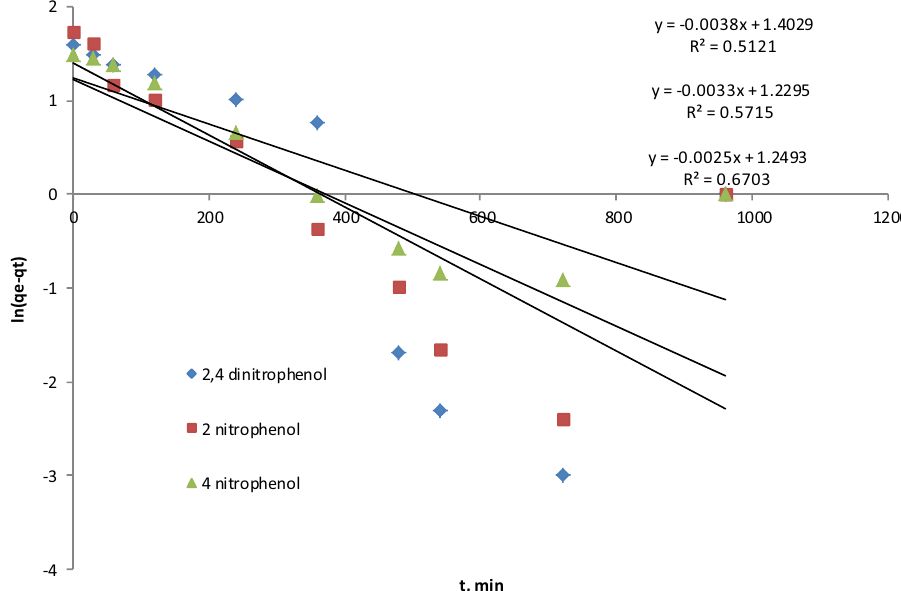
Fig. 9 First order model of phenols on char